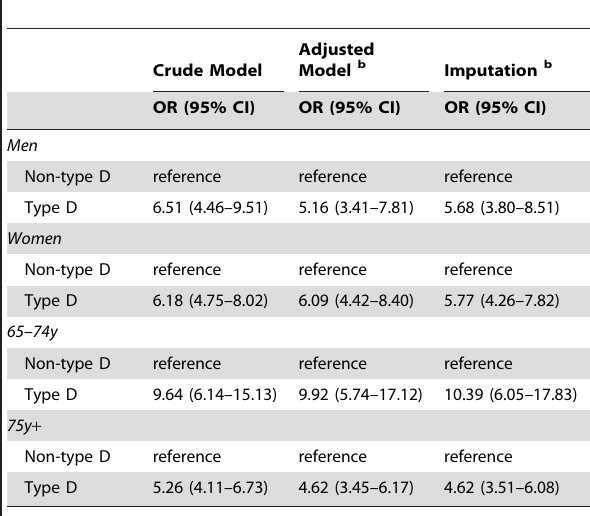
Table 4. Odds ratios for severe psychological distress a associated with Type D personality, Japan, 2010.